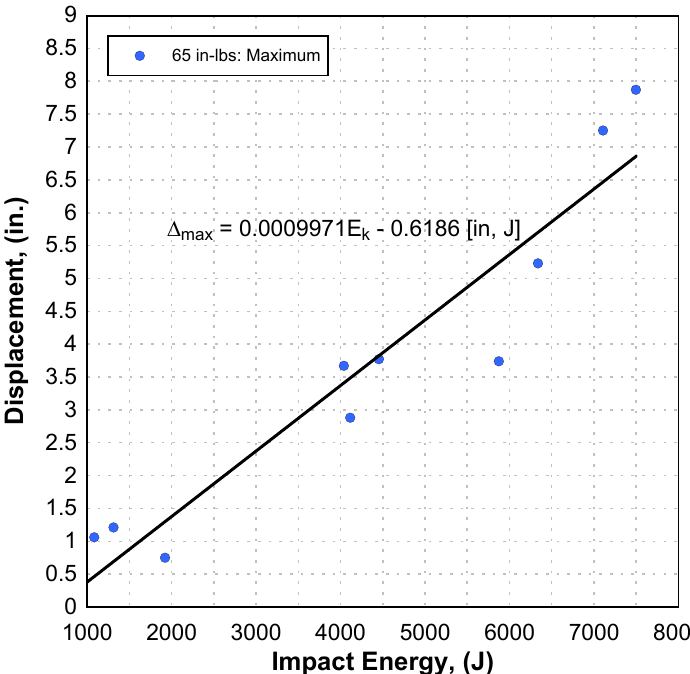
Figure 30. Maximum inbound displacements for five-laminae